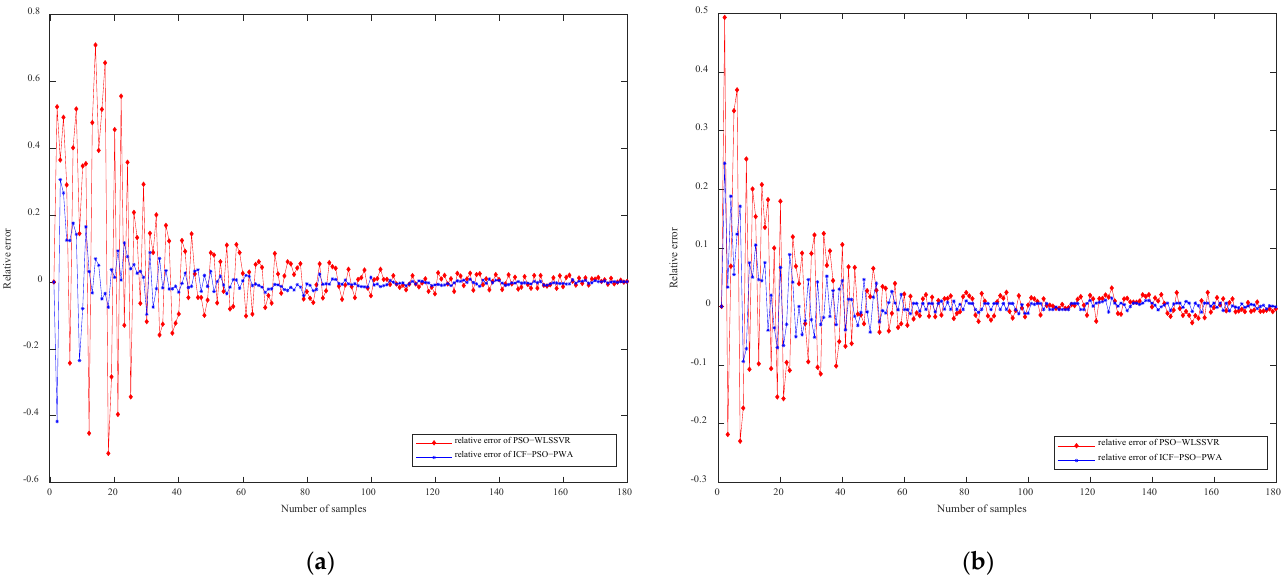
Figure 7. Comparison curve of relative error of ( a ) cell concentration and ( b ) protease K concentration. Table 2 shows the mean absolute percentage error (MAPE) of cell concentration and proteinase K concentration based on ICF-PSO-PWA and PSO-WLSSVR. It can be seen